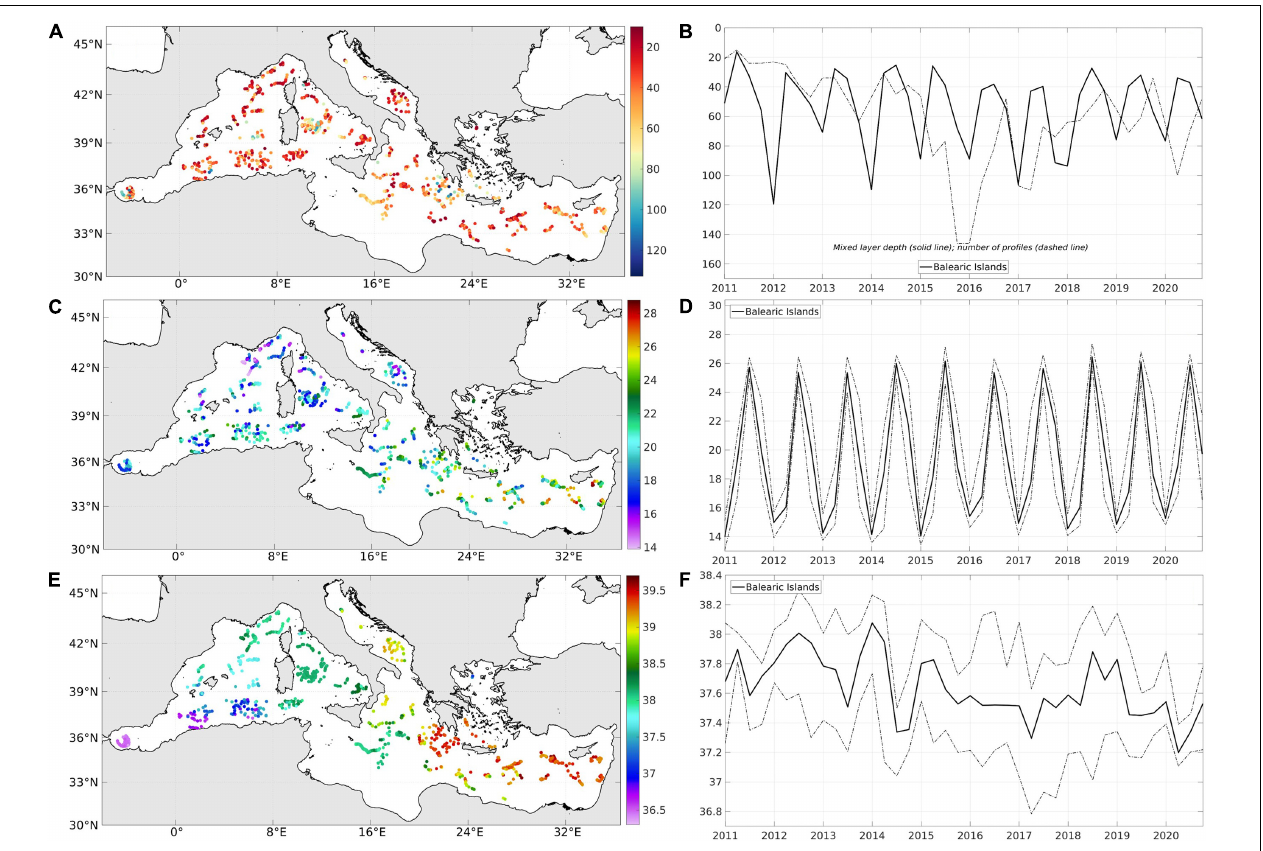
FIGURE 9 | Illustrations for the seasonal MLD (in m) (A,B) , MLT (in ◦ C) (C,D) , and MLS (E,F) : 2D maps of MLD (A) , MLT (C) , and MLS (E) in autumn 2020, and time series of the MLD maxima (solid line) with associated number of profiles (dashed line) (B) , and the MLT (D) and MLS (E) medians (solid lines), 17 and 83th percentiles (dashed lines) in the Balearic Islands since 2011. TABLE 4 | Summary of the diagnostics and illustrations for the vertically integrated indicators.